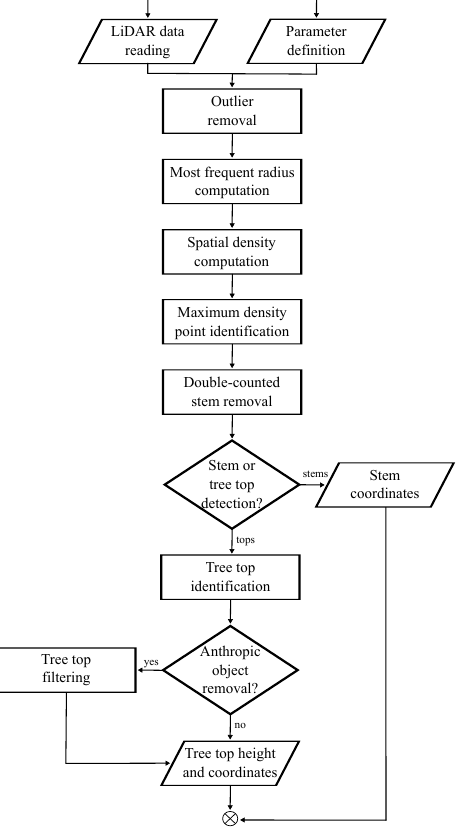
Figure 6. Conceptual representation of the individual tree identification